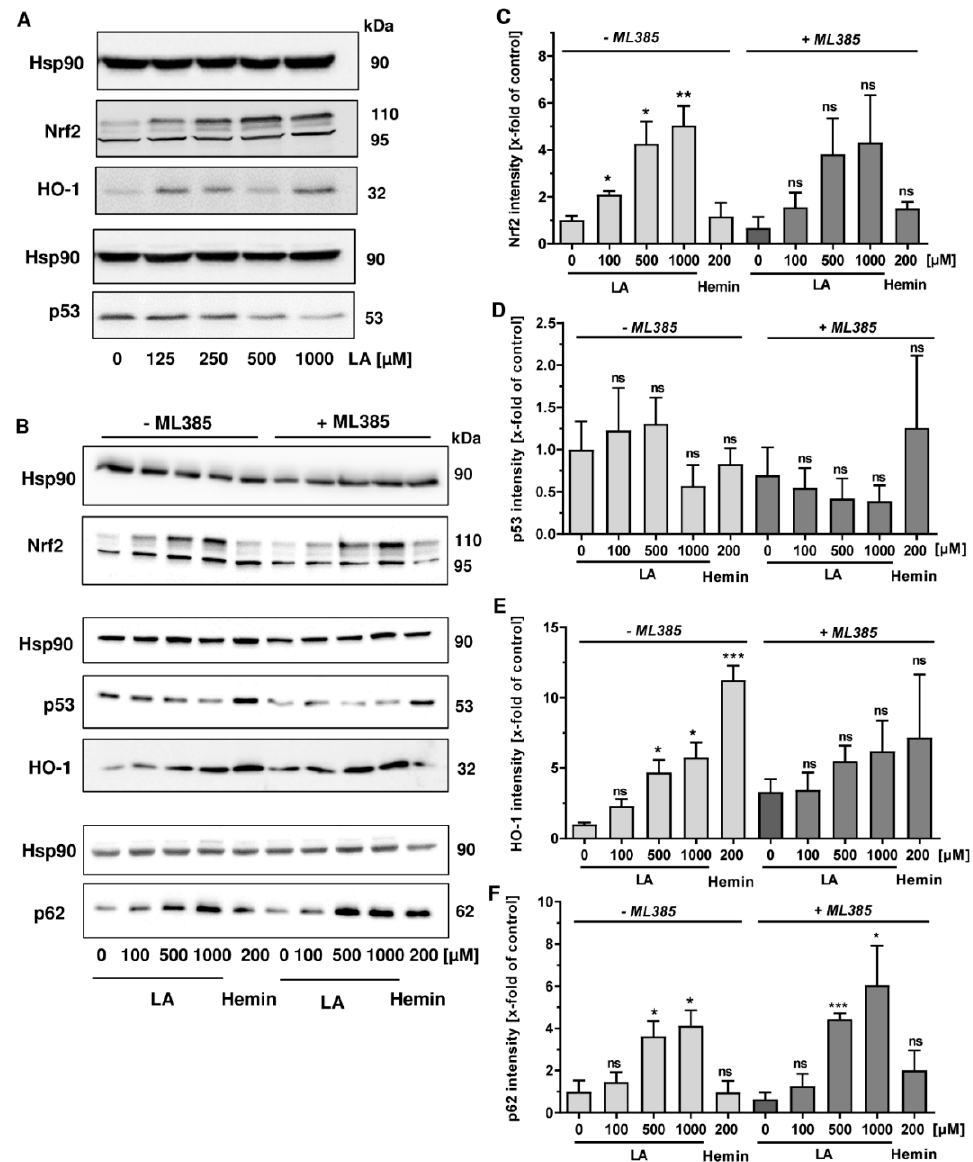
Figure 5. LA induces Nrf2, which is likely dispensable for p53 degradation. ( A ) HCT116 cells were incubated with increasing doses of LA (125–1000 µM) for 48 h. Cells were thereafter subjected to SDS- PAGE and western blot analysis of p53, Nrf2 and its downstream target HO-1. EtOH (0 µM) served as solvent control. Hsp90 was visualized as loading control. ( B ) HCT116 cells were incubated for 48 h with LA in the presence or the absence of ML385, a pharmacological Nrf2 inhibitor. Hemin (200 µM, 24 h) was included as positive control for HO-1 induction. EtOH (0 µM) served as vehicle control. Cells were then lyzed and underwent western blot analysis of Nrf2, p53, HO-1, as well as p62. Hsp90 was used as loading control. ( C – F ) Densitometric quantification of NRF2 (C), p53 (D), HO-1 (E)